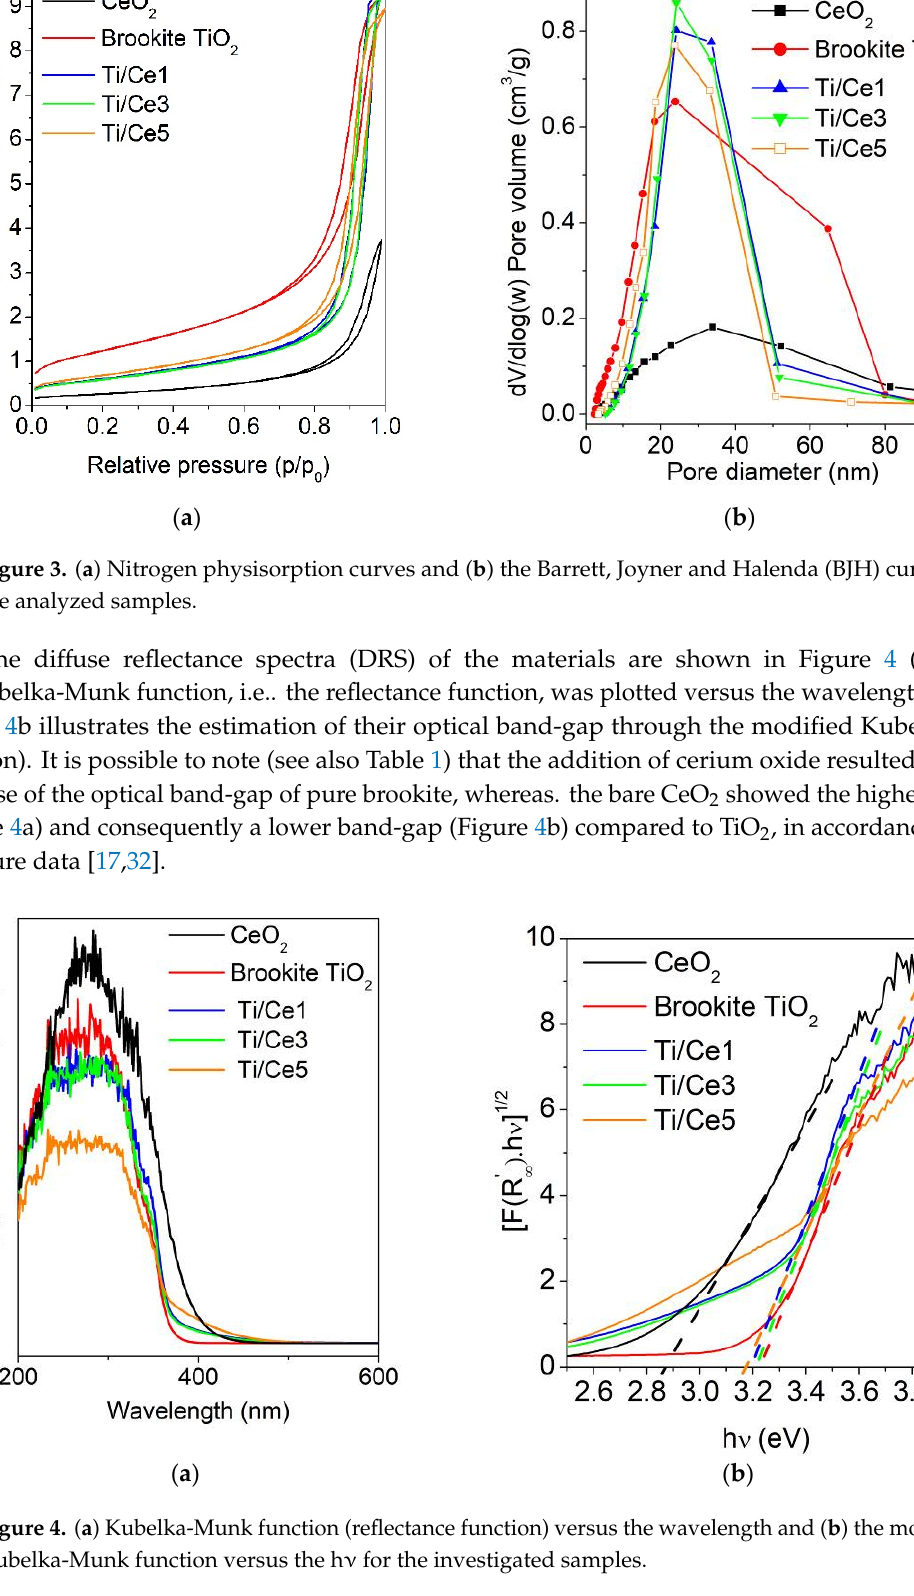
Figure 3. ( a ) Nitrogen physisorption curves and ( b ) the Barrett, Joyner and Halenda (BJH) curves of the analyzed samples. Table 1. Brunauer-Emmett-Teller specific surface area (S A ), mean pore diameter (d p ), pore volume (v p ) and optical band-gap (E g ) of the analyzed samples.